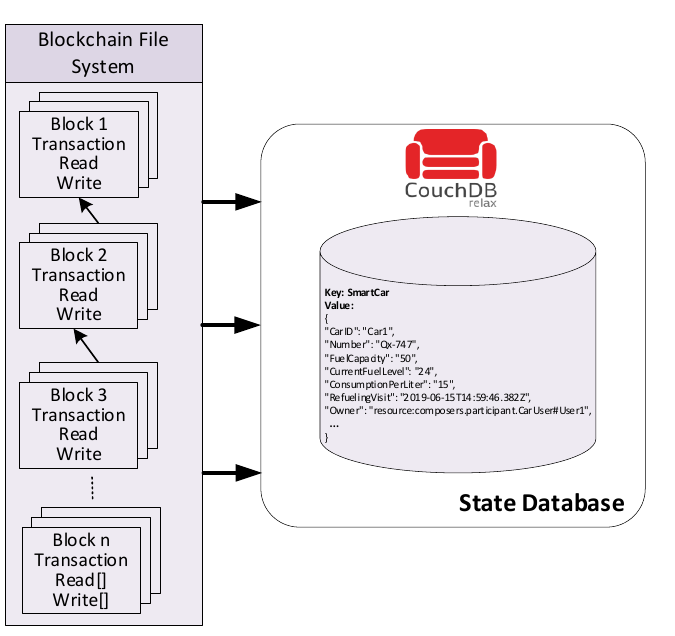
Figure 10. Distributed ledger storage structure of the proposed blockchain